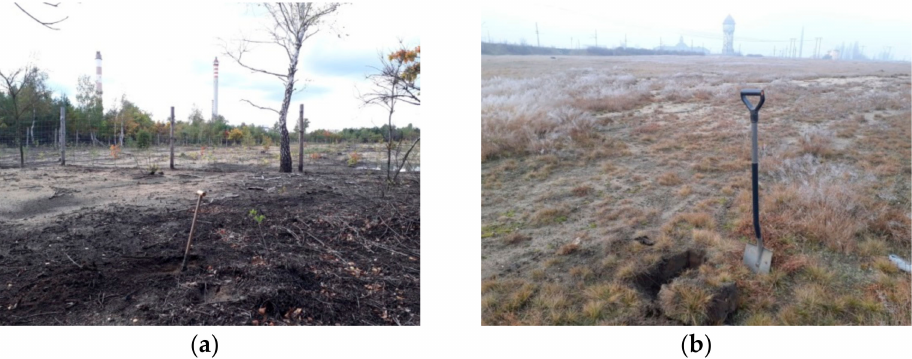
Figure 1. Soil sampling areas near the former “Miasteczko ´Sl ˛askie” zinc smelter ( a ) and non-ferrous metals steelworks “Szopienice” ( b